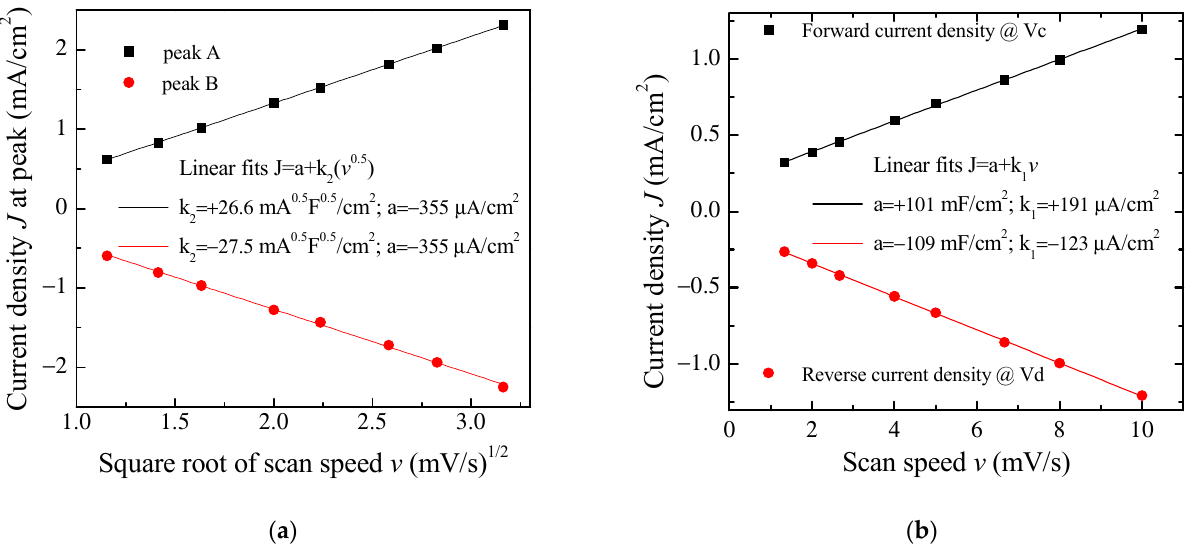
Figure 10. ( a ) Forward (reverse) current density J measured at peak A B of Figure 9, plotted as a function of the square root of the scan speed v , and linear best-fit data; ( b ) Forward (reverse) current density J measured at the voltage V c (V d ) of Figure 9, plotted as a function of the scan speed v and linear best-fit data.